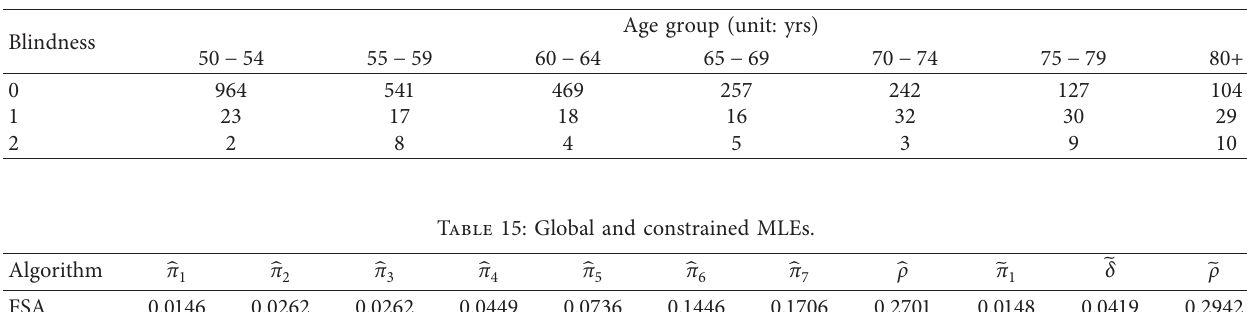
Table 14: Prevalence of avoidable blindness from a sample population in Iran.